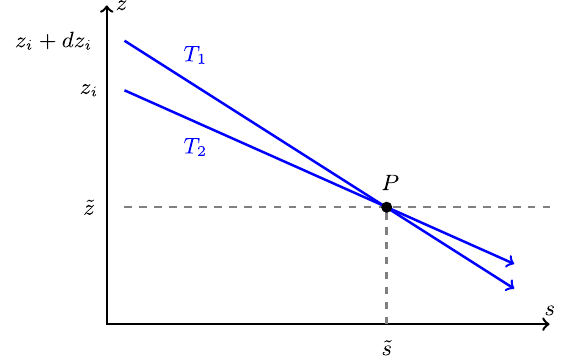
FIG. 5. Twoelectrontrajectories coalescingatthe causticpoint P